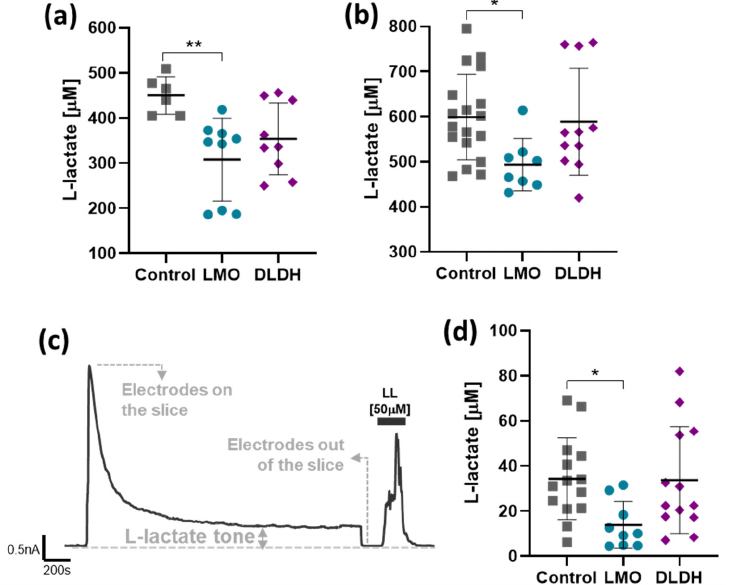
Figure 5. Effect of LMO or DLDH expression on constitutive lactate release. ( a ) Lactate concentration in media conditioned by HEK293 cells transfected with pCMV-IRES-EGFP (Control, n = 6), pCMV- LMO-IRES-EGFP (LMO, n = 9), or pTYF-EF1 α -DLDH-IRES-EGFP (DLDH, n = 9). ( b ) Lactate concentration in media conditioned by primary cultured astrocytes transduced with AVV-sGFAP- EGFP (Control, n = 17), AVV-sGFAP-LMO-IRES-tdTomato (LMO, n = 8), or AVV-sGFAP-DLDH-IRES- tdTomato (DLDH, n = 11). ** p < 0.01, * p < 0.05, one way ANOVA with Tukey multiple comparison test. ( c ) Representative trace of an amperometric recording following contact and stabilization of the lactate sensor with the surface of the organotypic slice culture. ( d ) Extracellular lactate tone of organotypic cultures transduced with AVV-PRSx8-EGFP alone (Control, n = 14) or in combination with AVV-sGFAP-LMO-IRES-tdTomato (LMO, n = 9) or AVV-sGFAP-DHDH-IRES-tdTomato (DLDH, n = 13). * p < 0.05, Kruskal–Wallis one-way ANOVA on ranks, followed by Dunn’s